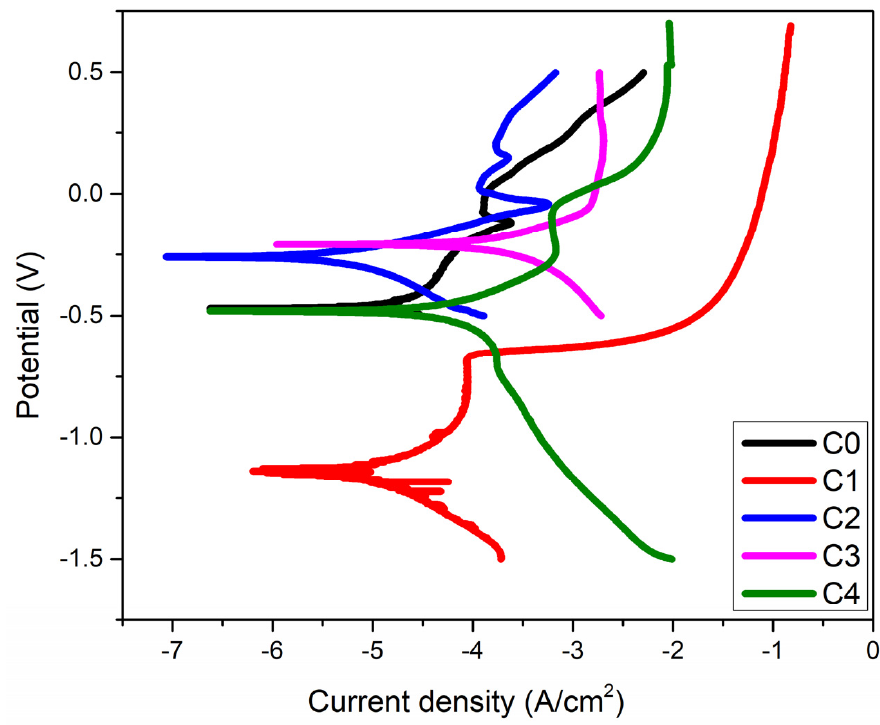
Figure 8. Potentiodynamic polarization curves for the cast samples.